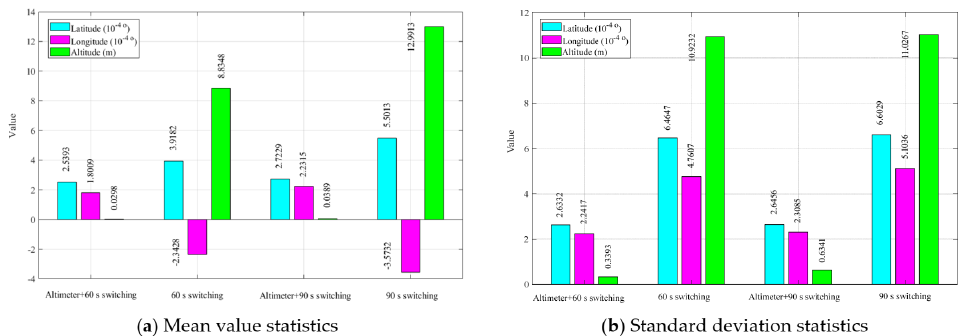
Figure 5. Under the same orbit, the navigation and positioning error statistics of the INS + LEO2 switching + unbiased altimeter algorithm and the INS + LEO2 switching algorithm when the switching time is 60 and 90 s,